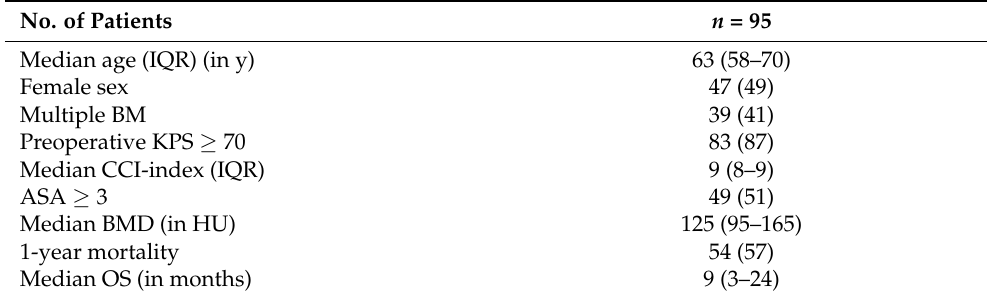
Table 1. Baseline characteristics